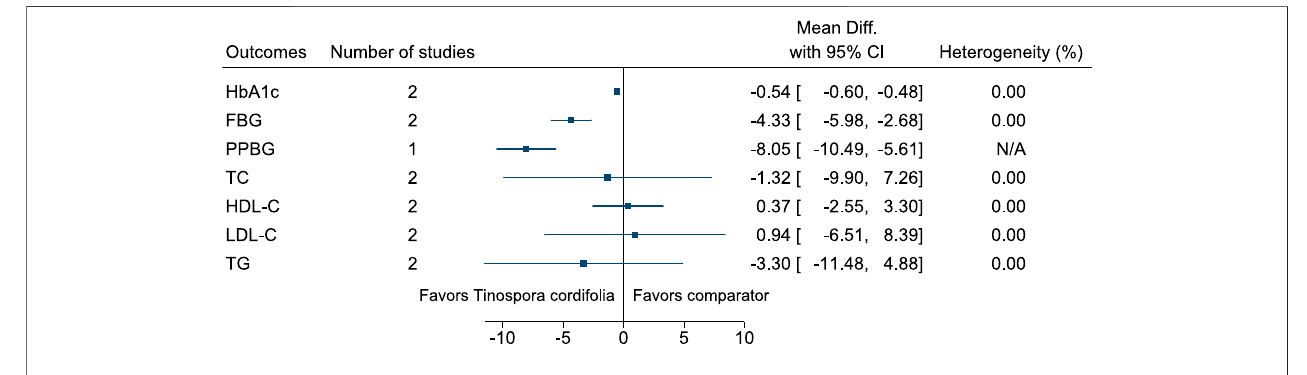
FIGURE 32 | Tinospora cordifolia — Summary forest plot.